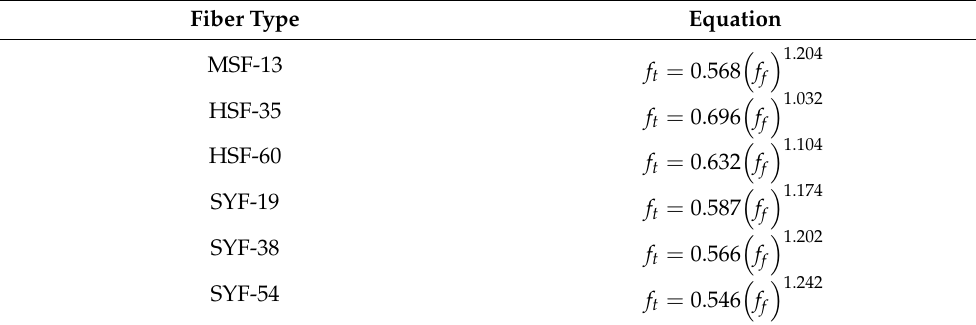
Figure 12. Relation between the tensile and flexural strengths of ( a ) MSF-13, ( b ) HSF-35, ( c ) HSF-60, ( d ) SYF-19, ( e ) SYF-38, and ( f ) SYF-54. Table 12. Summary of flexural strength and tensile strength